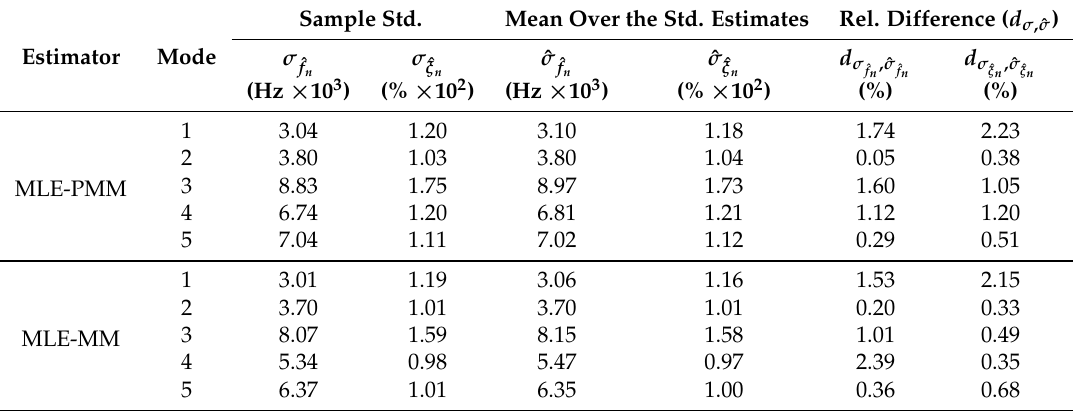
Figure 9. Monte Carlo simulation results for the identified natural frequencies ( a ) and damping ratios ( b ): sample mean and standard deviation (black line) and mean and standard deviation predicted after 10 iterations of MLE-PMM (red line) from a typical Monte Carlo dataset. Table 5. Monte Carlo simulation results obtained from the simulated EMA of the five-DOF system: comparison between the sample standard deviations and those predicted in a typical Monte Carlo run with the proposed MLE-PMM after 10 iterations.